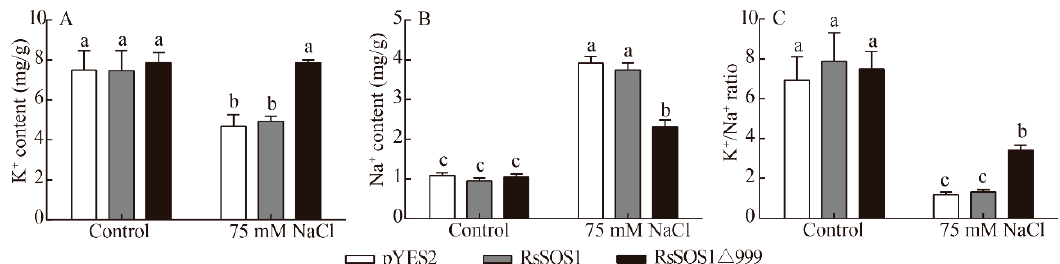
Figure 7. K + /Na + ion content in transgenic yeast: ( A ) Na + content; ( B ) Na + content; ( C ). K + /Na + ratio. Error bars indicate SD, letters represent significant differences at p < 0.05 level based on Duncan’s test.